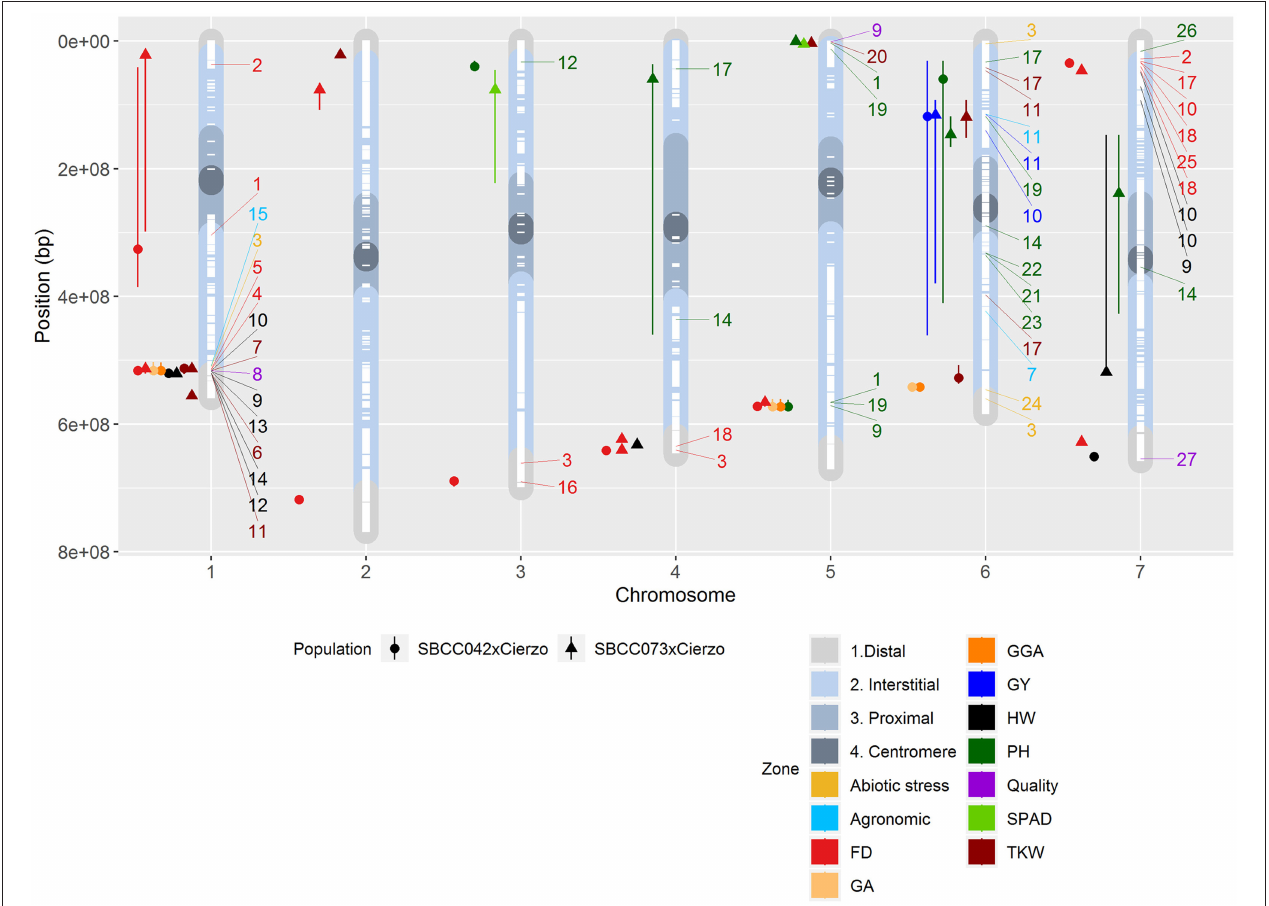
FIGURE 3 | Physical positions of the QTLs identified in the two populations on the seven chromosomes (X-axis): circles, QTLs in SBCC042 × Cierzo; triangles, QTLs in SBCC073 × Cierzo. Chromosome regions represented in color shades: distal in light gray, interstitial in light blue, proximal in gray, and centromere in dark gray. White dashes represent the presence of polymorphic markers in both populations. Colored icons to the left of each chromosome represent the location of a QTL, with whiskers indicating the confidence intervals. FD, flowering date; GA, green area February 2016; GGA, greener area February 2016; HW, hectoliter weight; PH, plant height; TKW, thousand-kernel weight; GY, yield. Colored numbers to the right of each chromosome represent the location of a QTL in the literature: 1, Wonneberger et al. (2017) ; 2, Alqudah et al. (2014); 3, Rollins et al. (2013); 4, Cuesta-Marcos et al. (2008); 5, Tondelli et al. (2014); 6, Haseneyer et al. (2010); 7, Locatelli et al. (2013) ; 8, Hassan et al. (2017); 9, Pauli et al. (2014); 10, Nice et al. (2017); 11, Sharma et al. (2018); 12, Rode et al. (2012); 13, Wang et al. (2012); 14, Mansour et al. (2014); 15, Schmalenbach et al. (2011); 16, Lakew et al. (2013); 17, Maurer et al. (2016); 18, Fisk et al. (2013); 19, Alqudah et al. (2016); 20, Mohammadi et al. (2015); 21, Teulat et al. (2001); 22, von Korff et al. (2008); 23, Baum et al. (2003); 24, Ingvordsen et al. (2015); 25, Maurer et al. (2015); 26, Al-Abdallat et al. (2017); 27, Houston et al. (2014). QTLs in the literature whose traits were related to those in our study are designated with the reference number and a color code according to a general trait classification: agronomic represents threshability, grain width and spikes m − 2 ; abiotic stress denotes aboveground mass and growth vigor; and quality represents arabinoxylan content, grain plumpness and ß-glucan